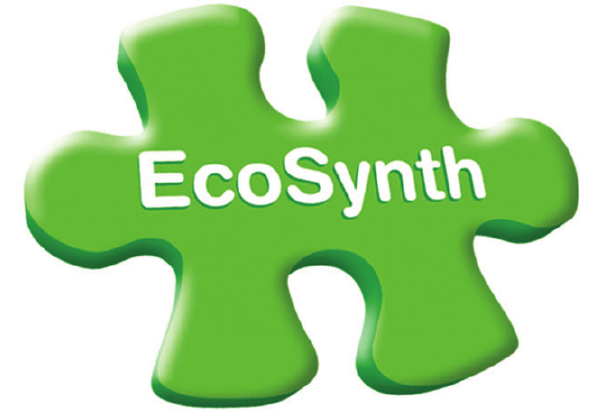
Figure 2 EcoSynth, the piece that completes your research